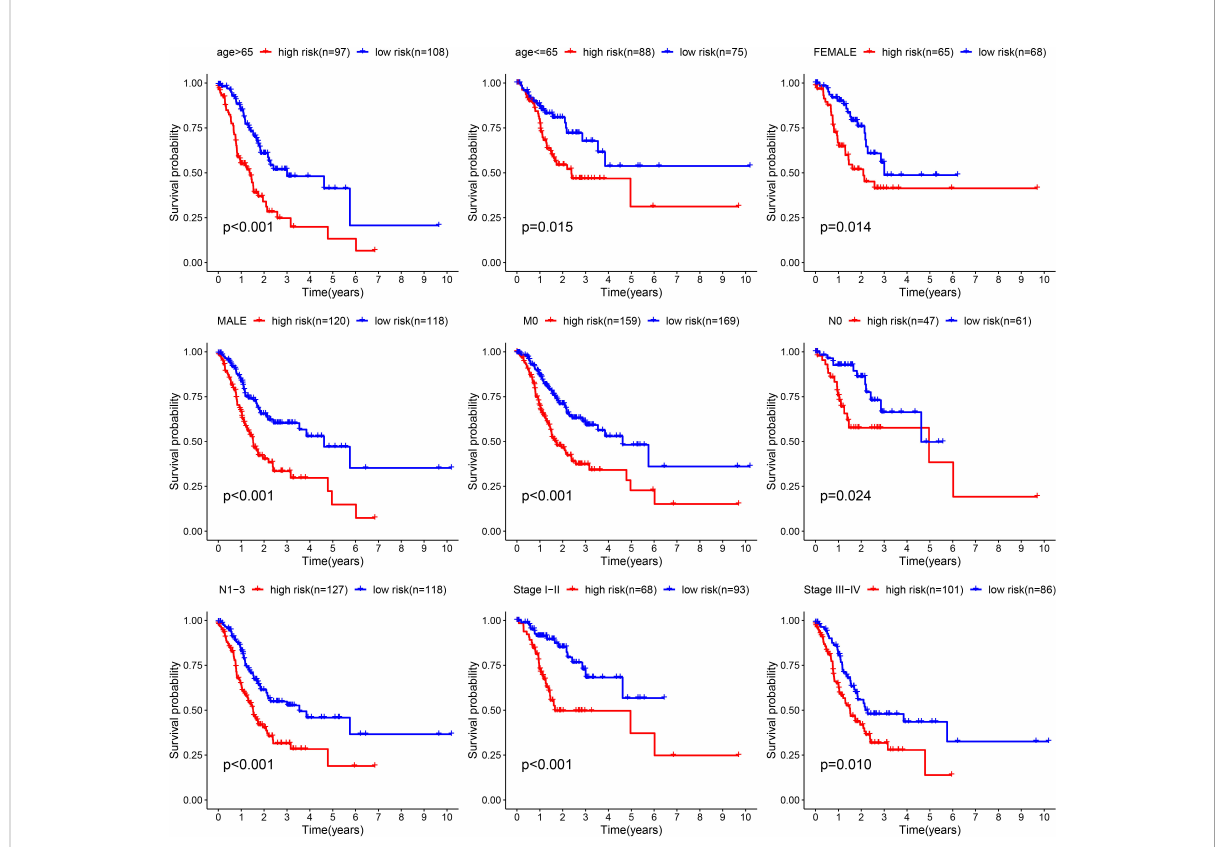
FIGURE 4 Validation of the prognostic value of ARGs signature in different clinical characteristics